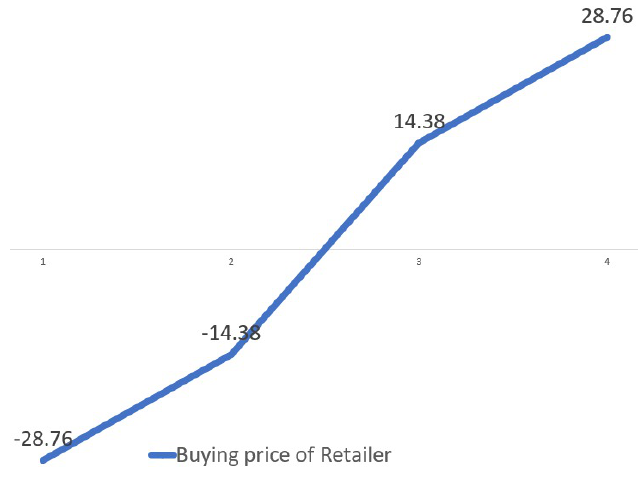
Figure 8. Effect of change of total cost for change of buying price of